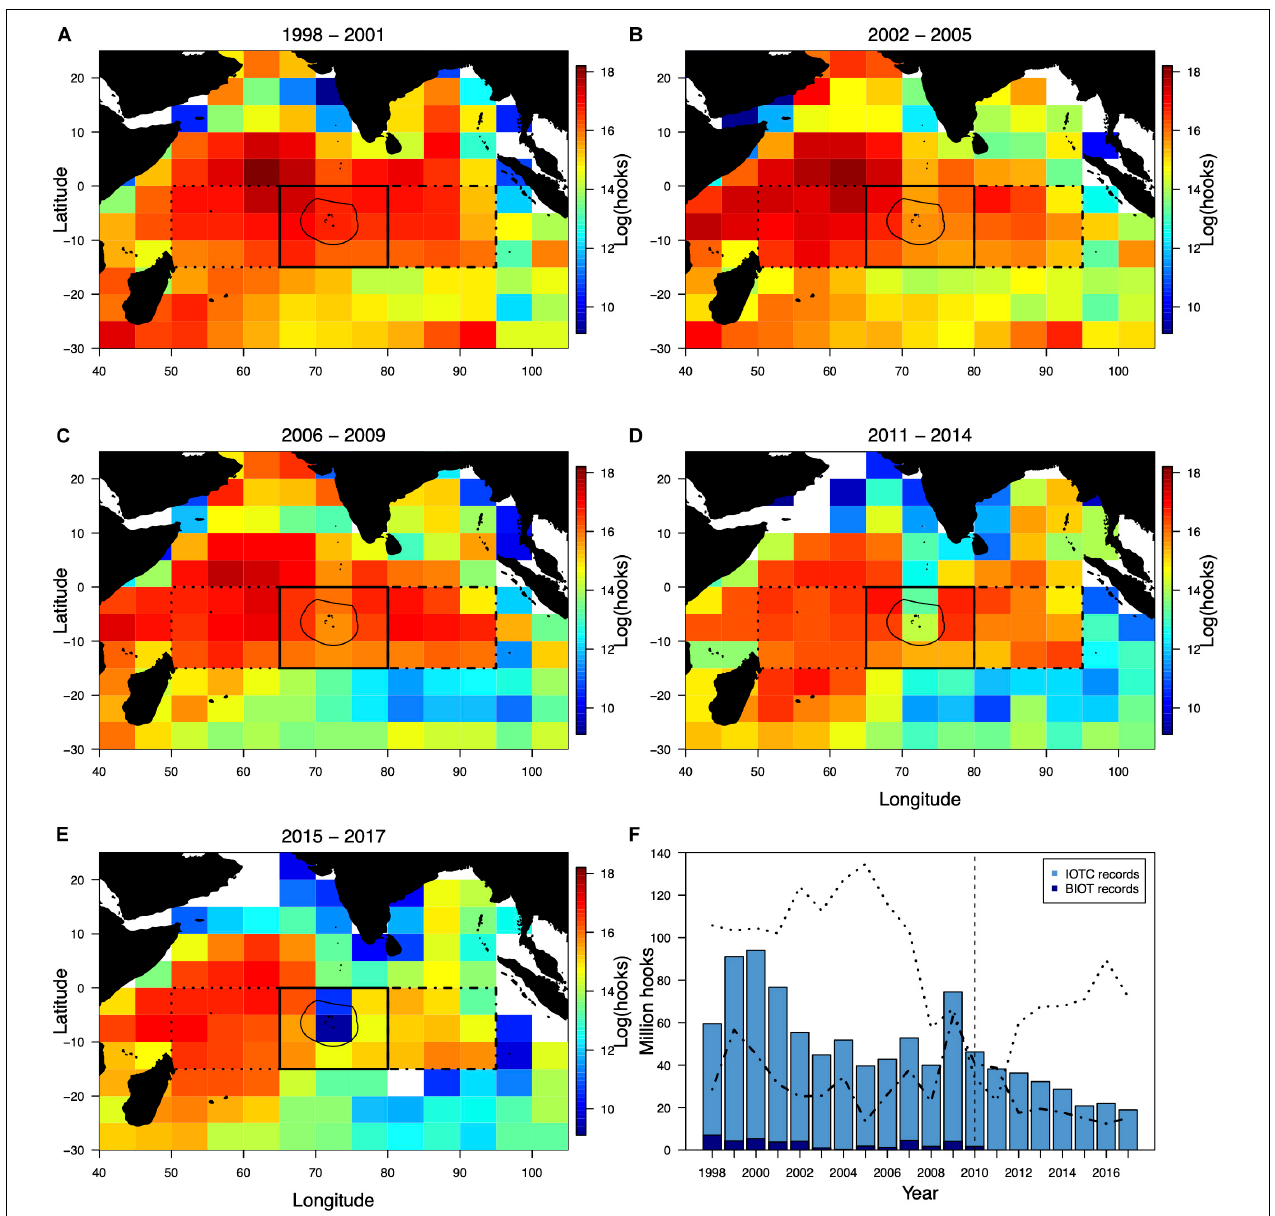
FIGURE 3 | The spatial distribution of mean annual longline hooks set (on a natural logarithm scale) by Indian Ocean Tuna Commission reporting grid cell between (A) 1998–2001, (B) 2002–2005, (C) 2006–2009, (D) 2001–2014, and (E) 2015–2017. Effort data for 2010 were excluded from spatial plots as this was a transition year in the British Indian Ocean Territory (BIOT) with the BIOT marine protected area (MPA) declared in April and the last fisheries license expiring in October. The thin solid line denotes the BIOT MPA boundary with the western (dotted), eastern (dot-dash) and BIOT (thick solid) quadrants delineated (A–E) . Bars represent total numbers of hooks deployed within the BIOT quadrant each year within the IOTC database (F) . The darker blue sub-sections represent the number of hooks that were recorded within the BIOT exclusive economic zone specifically (from the BIOT longline fisheries dataset). Dotted line represents effort in the western quadrant. Dot-dash line represents effort in the eastern quadrant. Vertical dashed line denotes the BIOT MPA’s establishment in